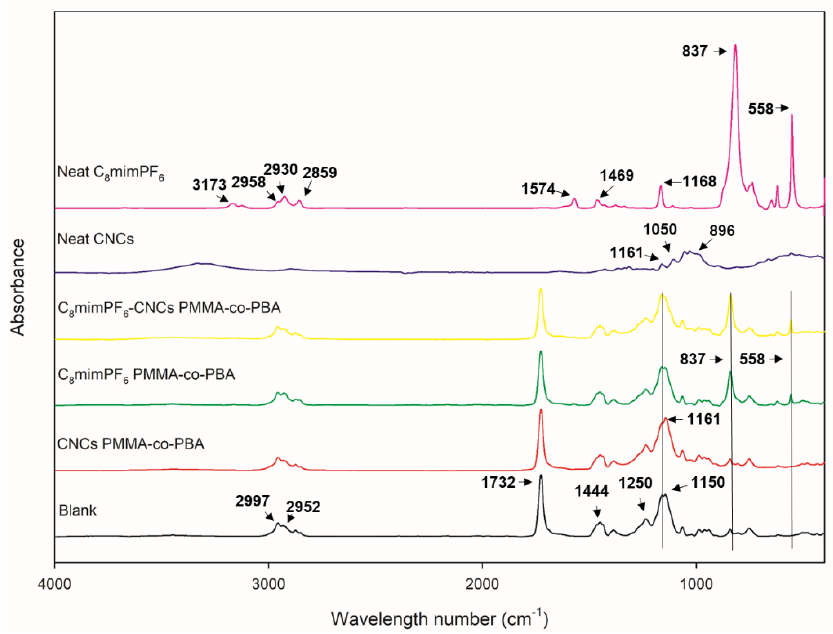
Figure 9. FTIR spectra for various